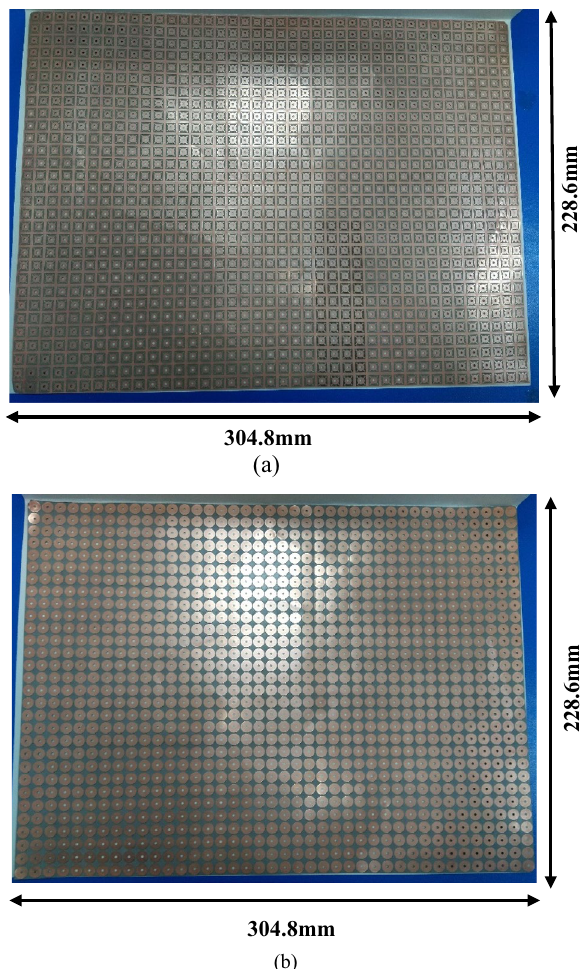
Figure 11. Fabricated prototype ( a ) Top layer ( b ) Bottom